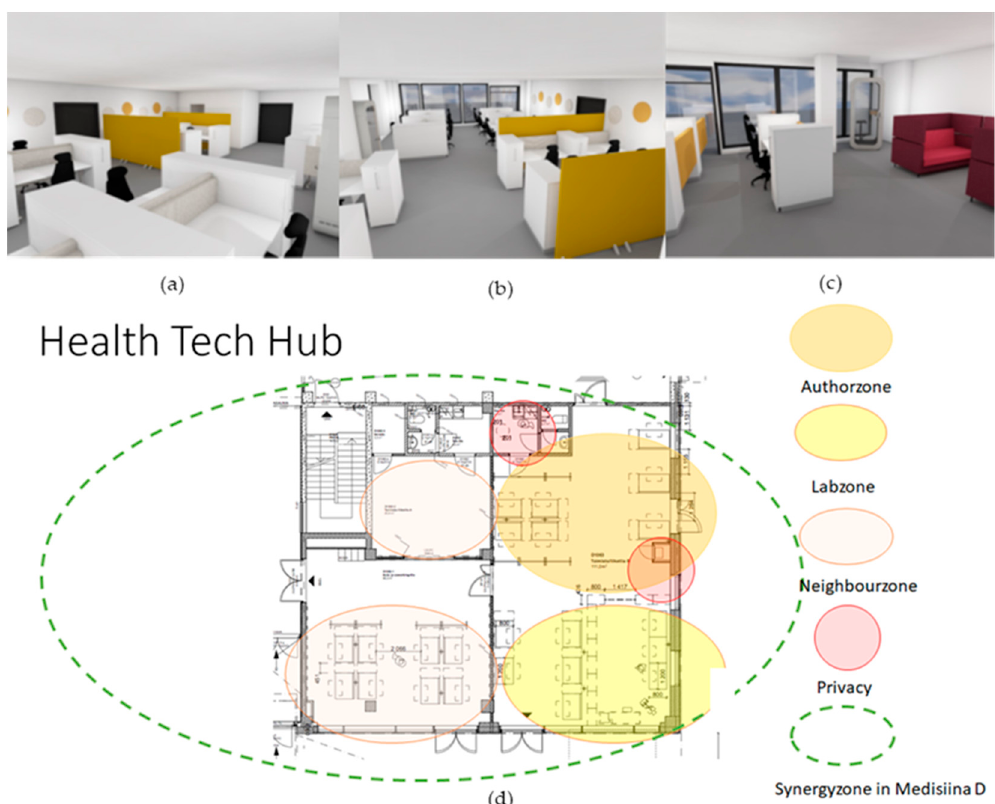
Figure 3. Case 1 working area divided into several zones with different activities. ( a ) Draft from the Lab-zone and Author-zone; ( b ) draft from the Author-zone to Lab-zone; ( c ) draft from the larger Neighbor-zone; ( d ) final floor plan.